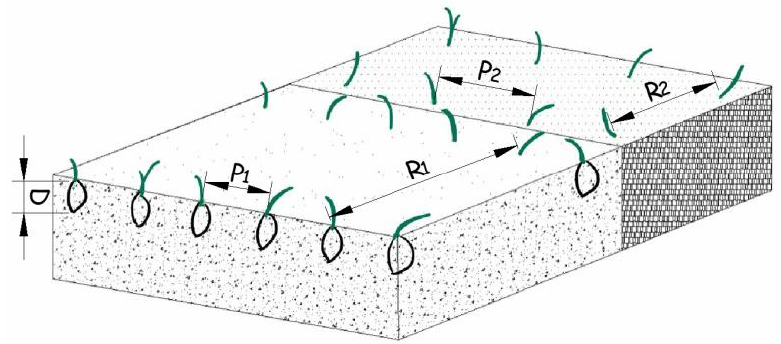
Figure 1. Diagram of agronomic requirements for garlic cultivation.